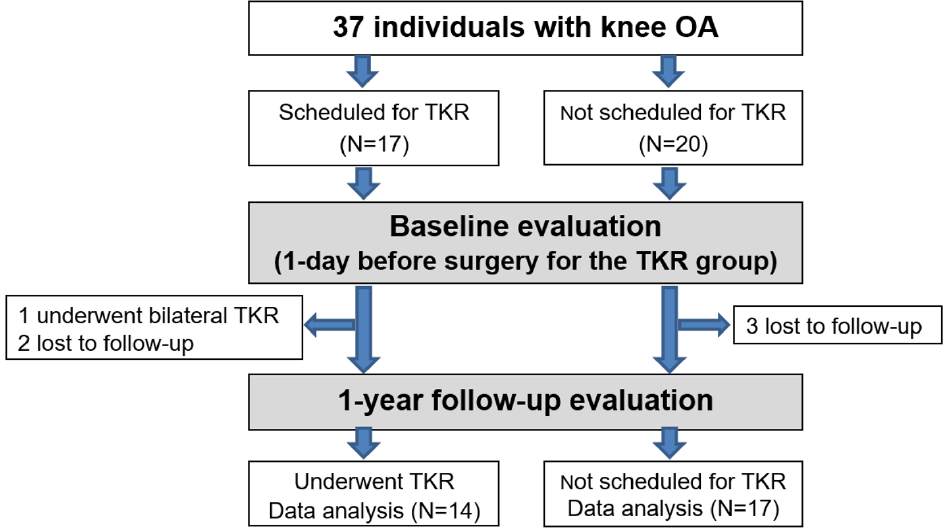
Figure 1. The study recruitment process and